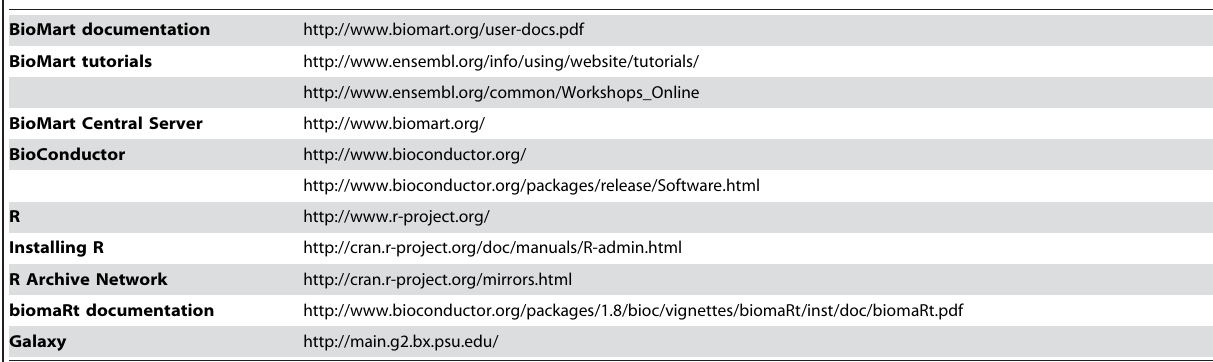
Table 1. URLs for additional